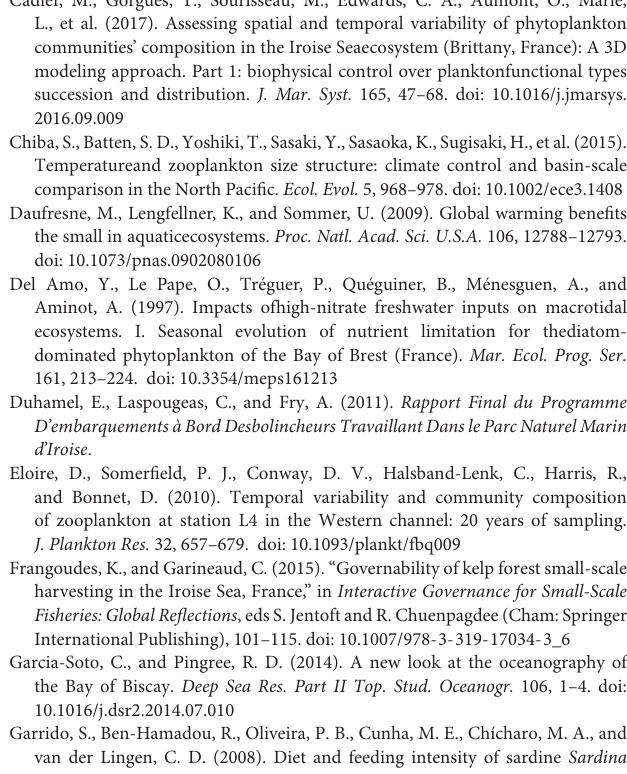
FIGURE S1 | Summary of all the sampling stations performed in the Parc Naturel Marin d’Iroise over the 2011–2015 period (name, date, coordinates, sampling depth, and sampled abiotic and biotic variables). TABLE S1 | Table summarizing the cell counts (cells/mL) for all the phytoplankton taxa identified to the lowest taxonomic level possible from the sampling cruises carried out in the Parc Naturel Marin